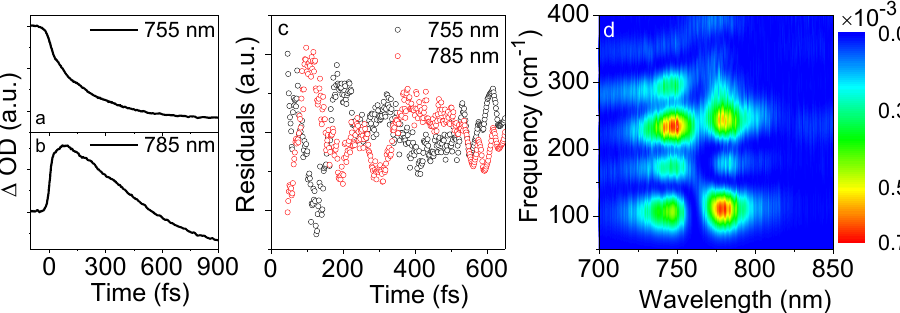
Fig. 2. (a, b) Temporal evolutions, and (c) Residual modulations at 755 and 785 nm for MAPbI 3 films. (d) Two dimensional map of Fourier power for MAPbI 3 films. The x -axis presents dispersed probe wavelength while the y -axis denotes Fourier frequency. The Fourier power is depicted by color coding according to the ruler show in the